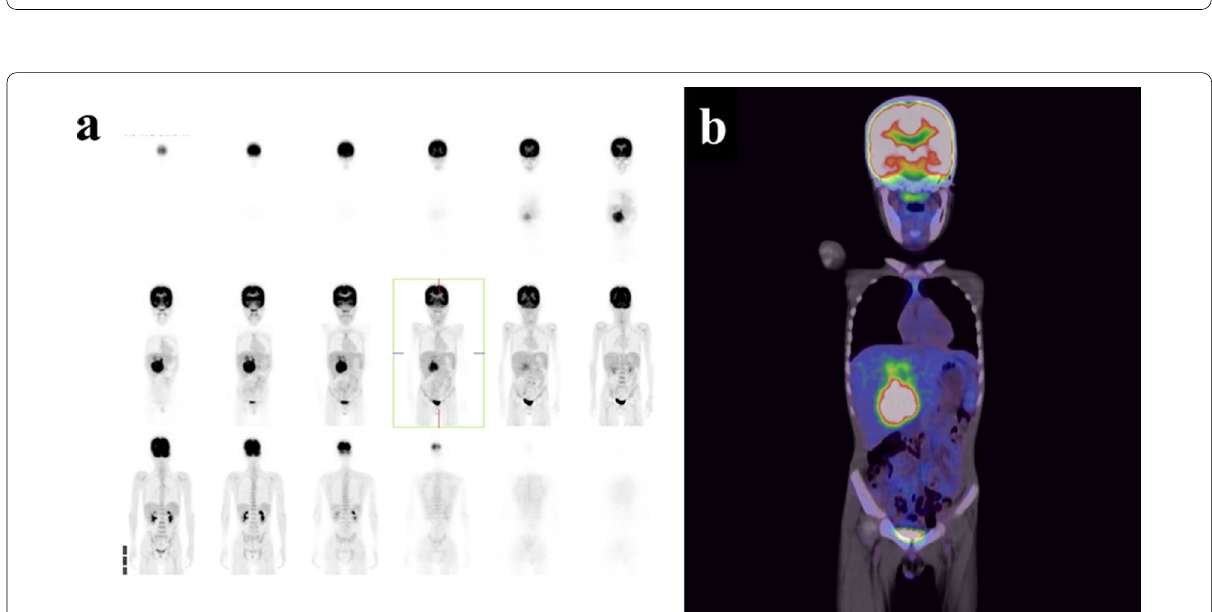
Fig. 3 FDG-PET findings. FDG-PET shows the tumor to have a high FDG uptake (SUVmax: 8.8) ( b ) with no signs of distant metastasis ( a